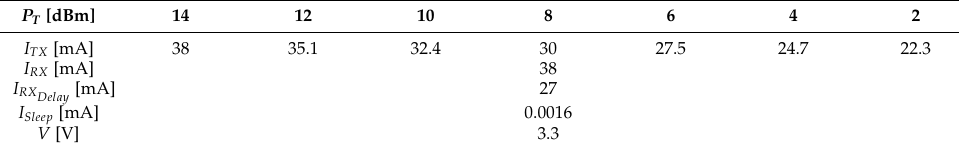
Table 8. Energy Consumption parameters